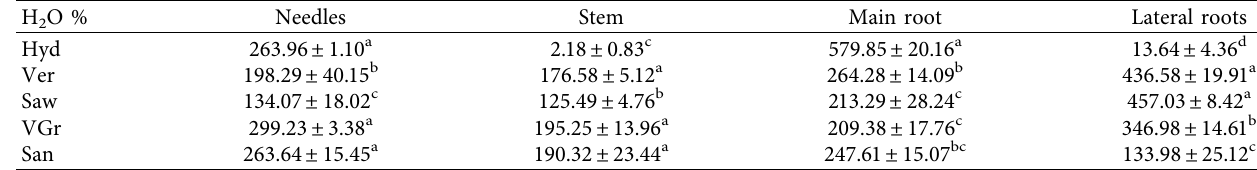
Table 2: Water content of cedar seedlings and its various